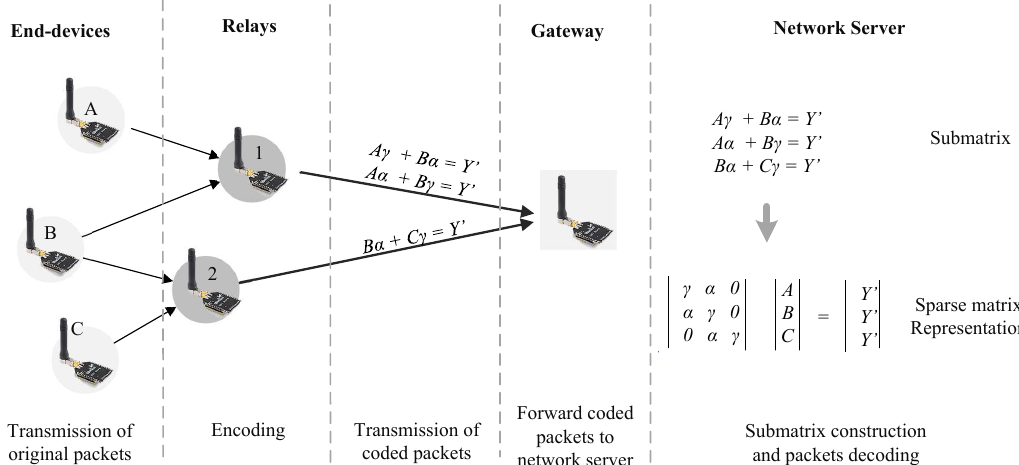
Figure 5. Network coding could recover linearly independent coded packets from different relays.